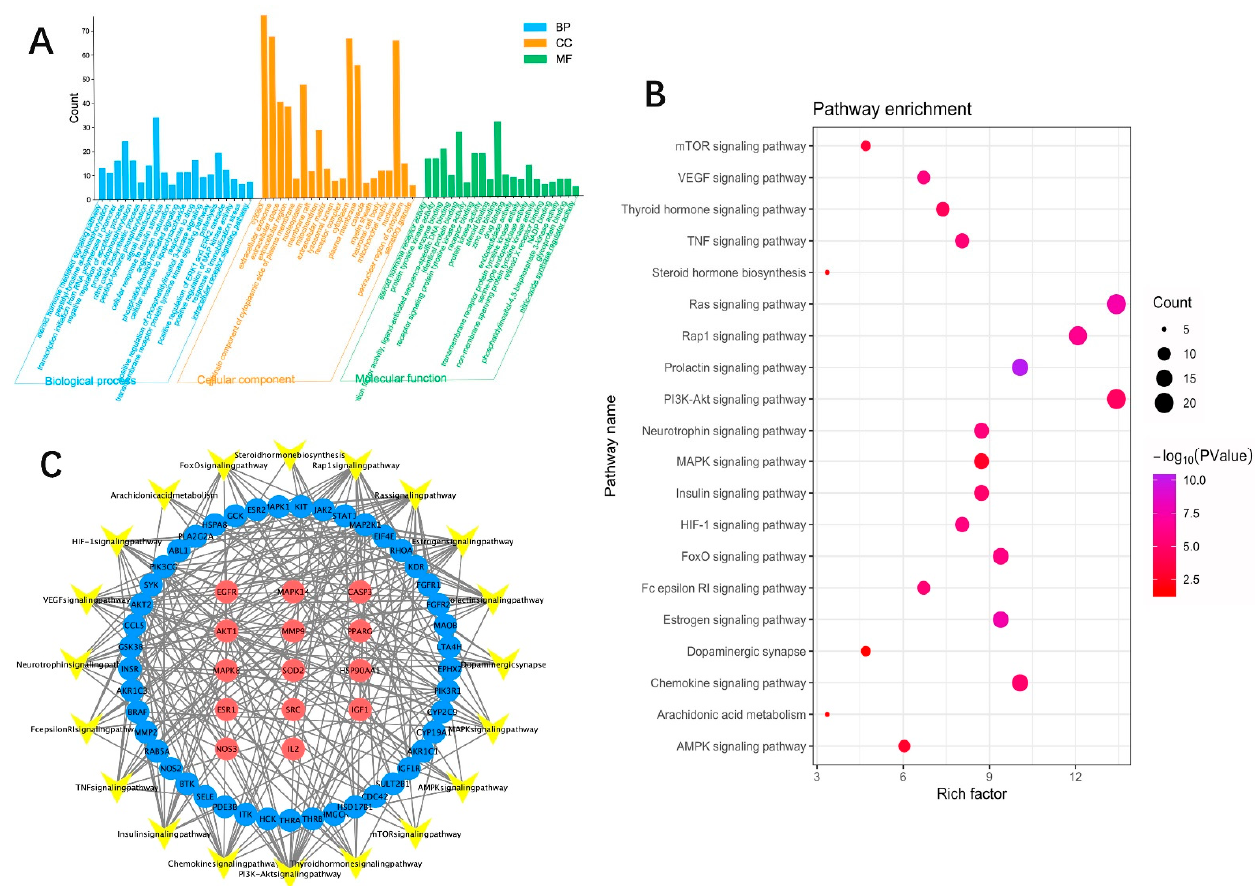
Figure 4. ( A ) GO function enrichment of ZZX-ACG–anxiety-related target. BP: Biological Process. CC: Cellular Component. MF: Molecular Function. ( B ) KEGG enrichment of ZZX-ACG–anxiety-related target. ( C ) Target–Pathway network of ZZX-ACG for anxiety.